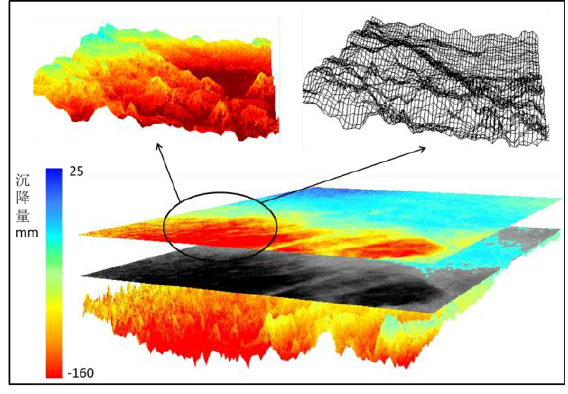
Figure 11. 3D map of land subsidence